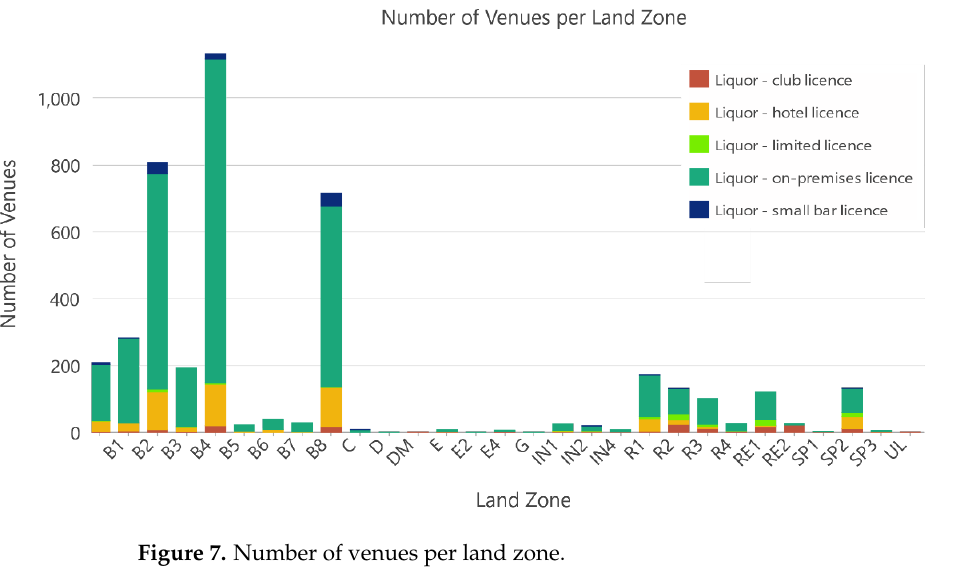
Figure 6. NSW Land use zones in 2021.